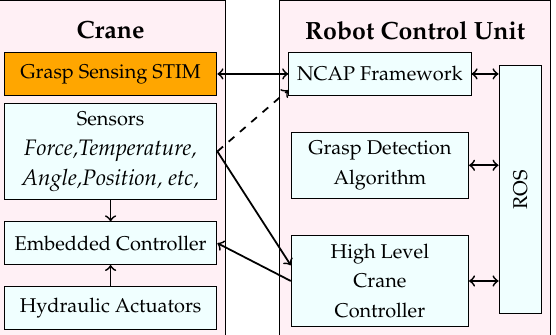
Figure 4. High level data acquisition and processing framework. The crane consists of various sensors for monitoring and hydraulic system for actuating the position control. It also has an embedded controller for controlling the crane based on external from the high level controller. The designed grasp sensing system (STIM) is mounted on the crane in a protective cavity. The STIM communicates to the Network Capable Application Processor (NCAP) framework in the host computer via BLE; the obtained data is then used for further processing and passed to a program using Robot Operating System